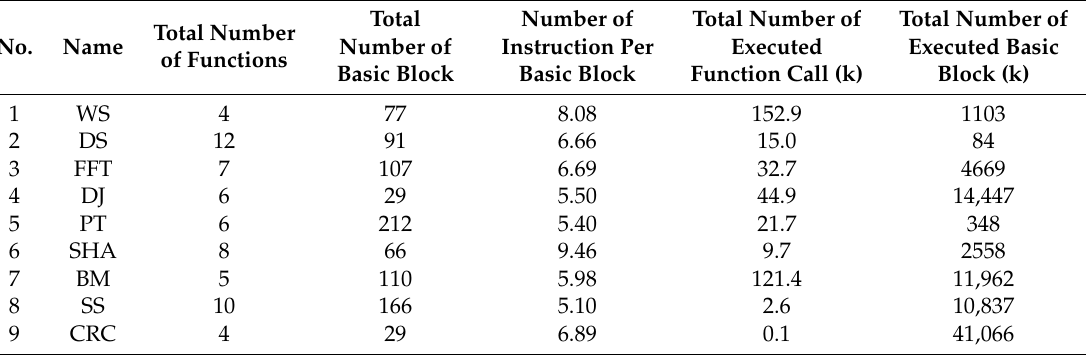
Table 1. Benchmarks: Whetstone (WS), Dhrystone (DS), fast Fourier transform (FFT), Dijkstra (DJ), Patricia (PT), secure hash algorithm (SHA), basicmath (BM), stringsearch (SS), cyclic redundancy check